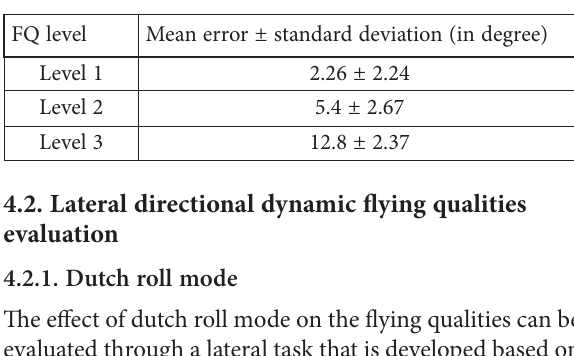
Table 10. Performance scores for SOS tracking task